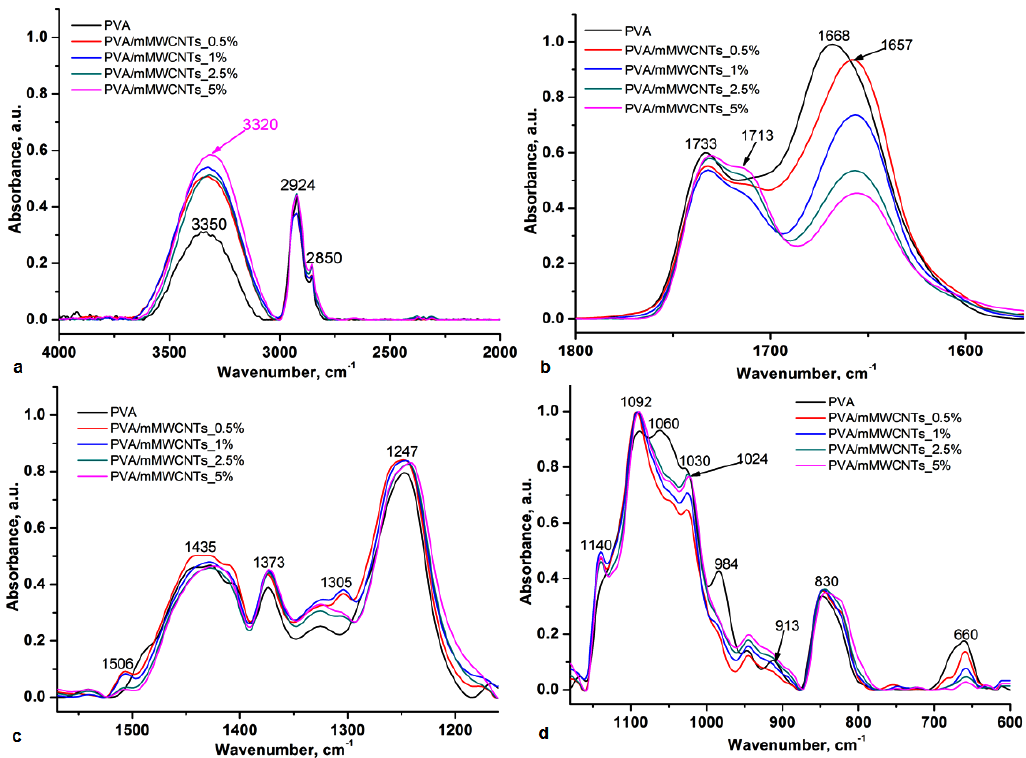
Figure 3. ATR–FTIR spectra of the PVA/mMWCNTs composite system in the O-H spectral region ( a ), 1800–1500 cm ‒ 1 ( b ), 1600–1200 cm ‒ 1 ( c ), and 1200–600 cm ‒ 1 ( d ) spectral range. As depicted in Figure 3b, all spectra show two absorption bands at 1733 and 1668 cm ‒ 1 ,which are attributed to C=O of acetate groups present in the PVA matrix. For the PVA/mMWCNTs composites system, the absorption due to the carbonyl groups is de-